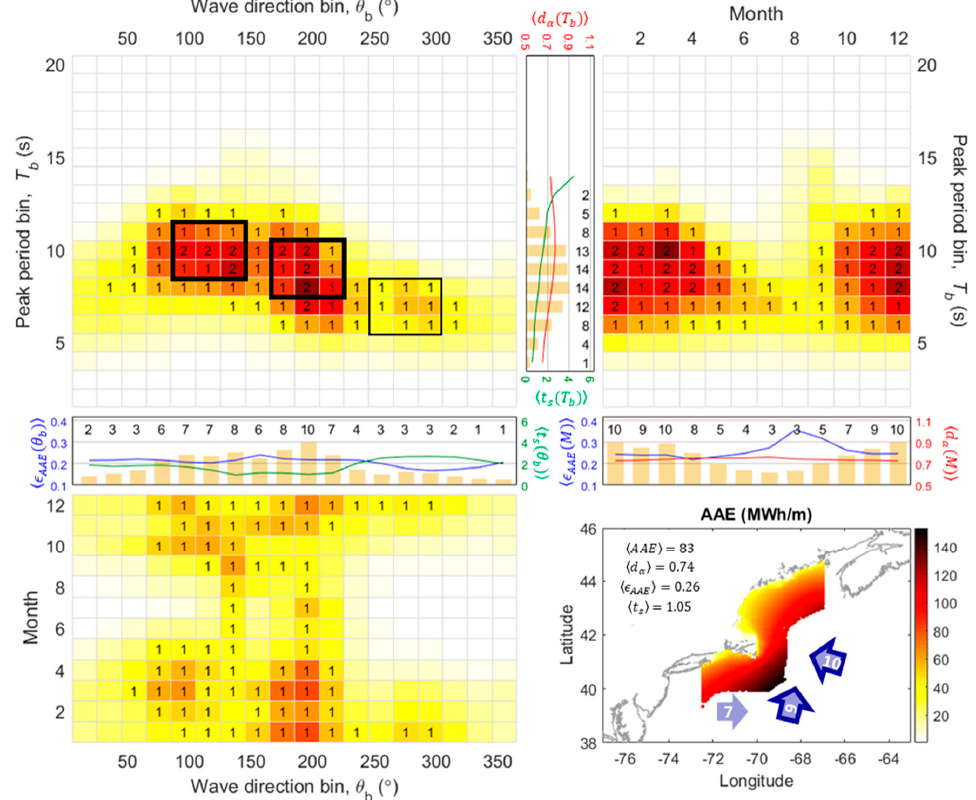
Figure 11. [Region 10: Atlantic—North Coast] The detailed descriptions are identical to Figure 2.